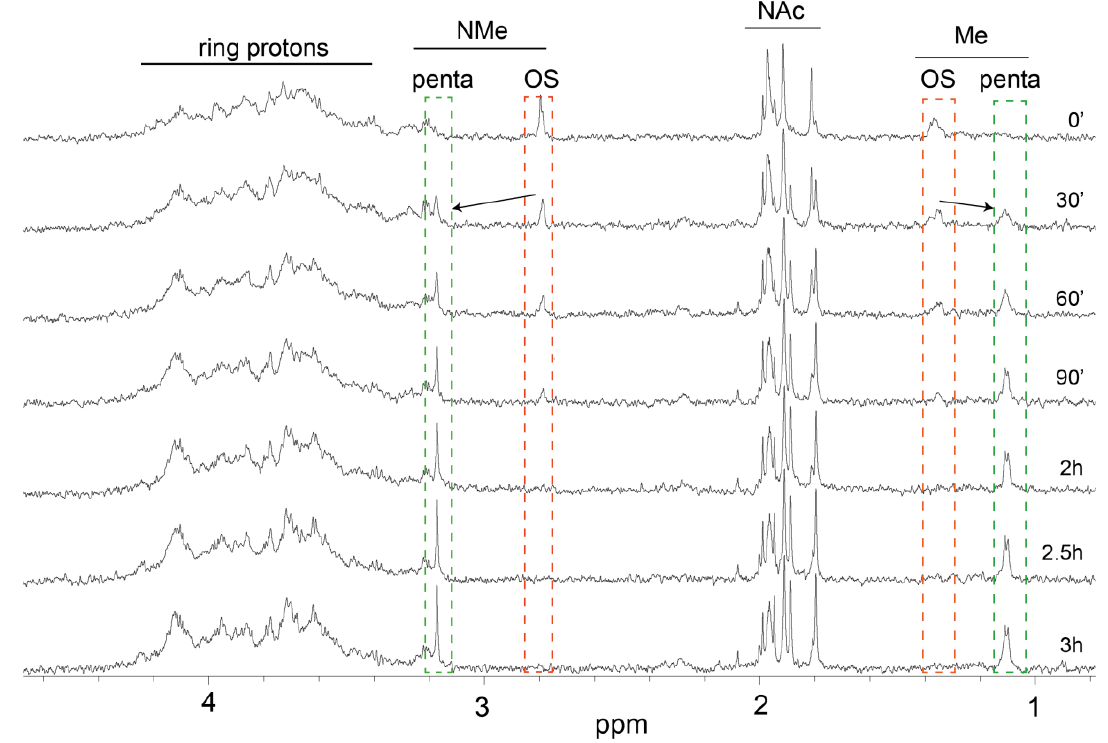
Figure 5. In vitro chemical simulation of B. pertussis 186 OS deamination traced by kinetic NMR approach. The reaction was carried out in a capillary NMR tube [ ∅ 1.7 mm] and the course of reaction was monitored by a series of NMR measurements with 30 min intervals for 3 h. The spectra were acquired in a pseudo-2D experiment on a Bruker Avance III 600 MHz spectroscope at 298K, using inverse TXI microprobe.